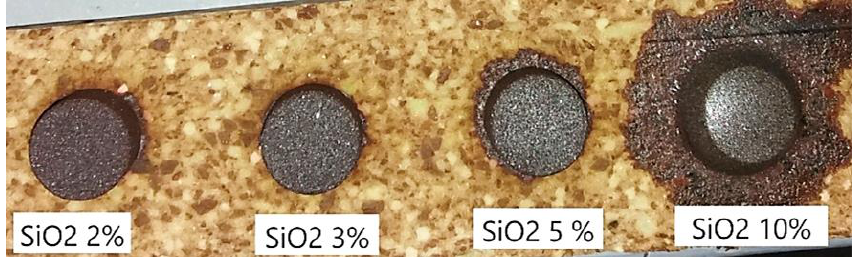
2 addition after